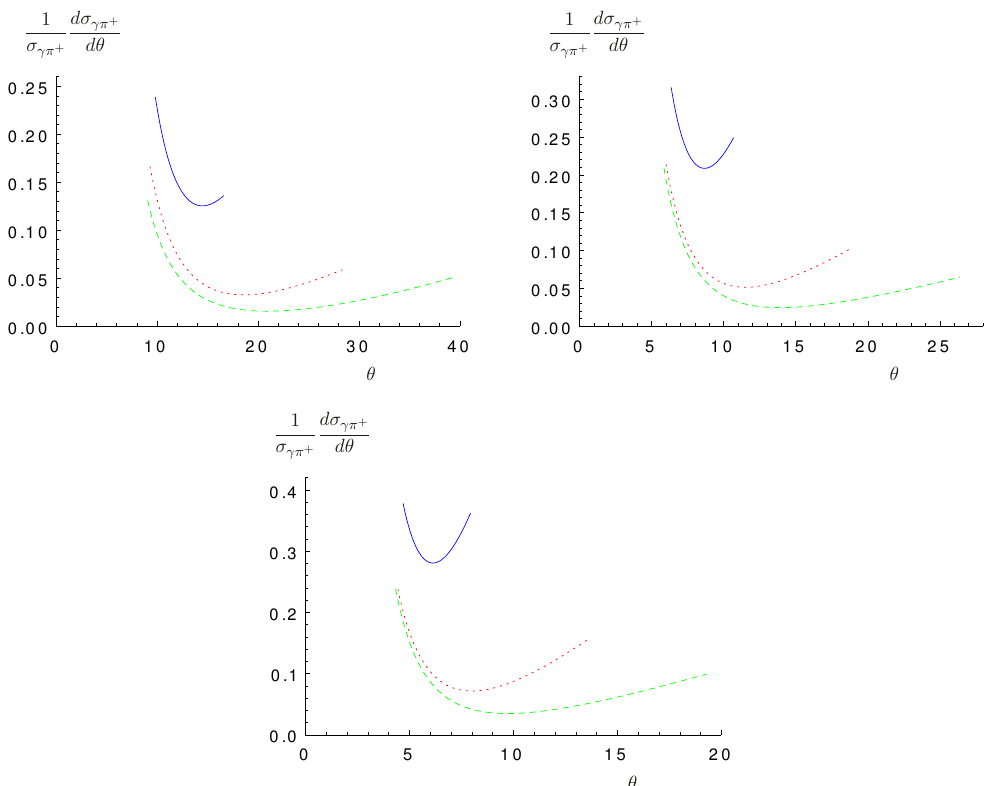
Figure 13 . Angular distribution for γπ + pair production on a proton target. Up, left: S γN = 10 GeV 2 . Up, right: S γN = 15 GeV 2 . Down: S γN = 20 GeV 2 . In all three cases, the plots are shown for M 2 = 2 GeV 2 (solid blue), M 2 = 3 GeV 2 (dotted red) and M 2 γπ + γπ + (dashed